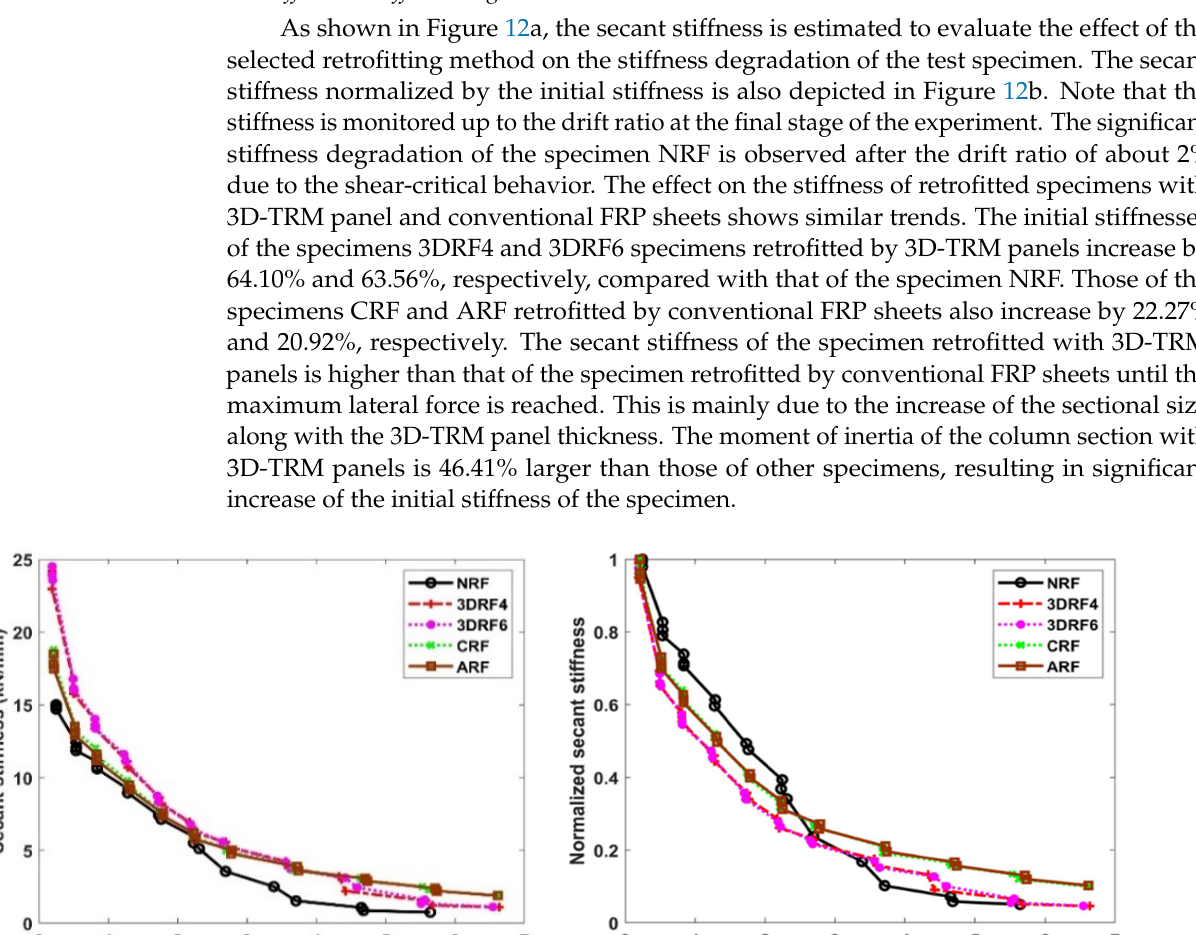
( b ) Figure 13. Effect on the energy dissipation: ( a ) Energy dissipation per cycle; ( b ) Cumulative energy dissipation. 4.6. Effect on Strain Distribution In order to evaluate the effect on the strain distribution of specimens, longitudinal and transverse strains are monitored. Figure 14 shows the maximum strain at each critical